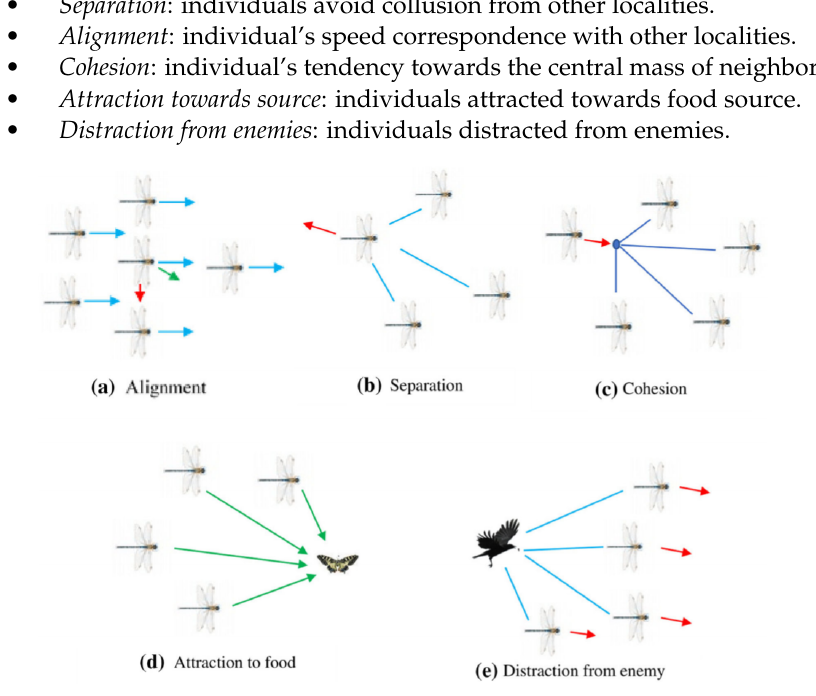
Figure 2. Primitive corrective patterns between dragonflies in a swarm (different steps of the artificial dragonfly